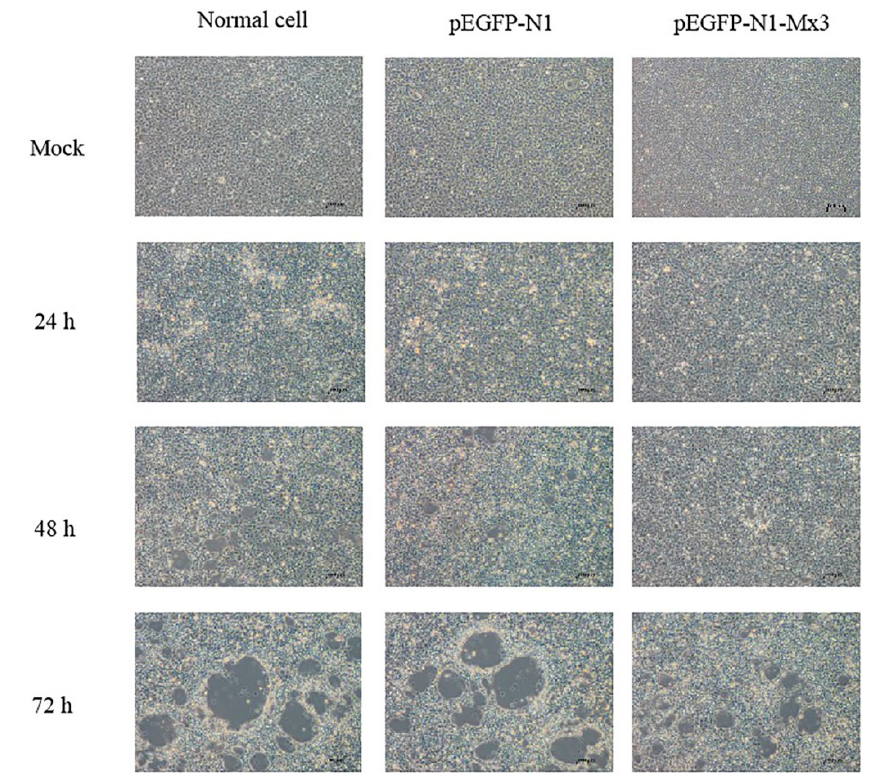
Figure 7. Morphology and cytopathic effect (CPE) of normal GSM cells, pEGFP-N1 transfected GSM cells and pEGFP-N1-AdMx transfected GSM cells at 0 h, 24 h, 48 h and 72 h post GSIV infection. Scar bar, 100 μ m.